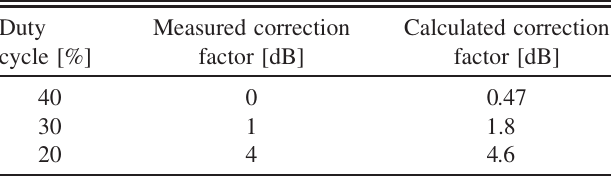
TABLE V. Comparison of measured and calculated correction factors for different duty